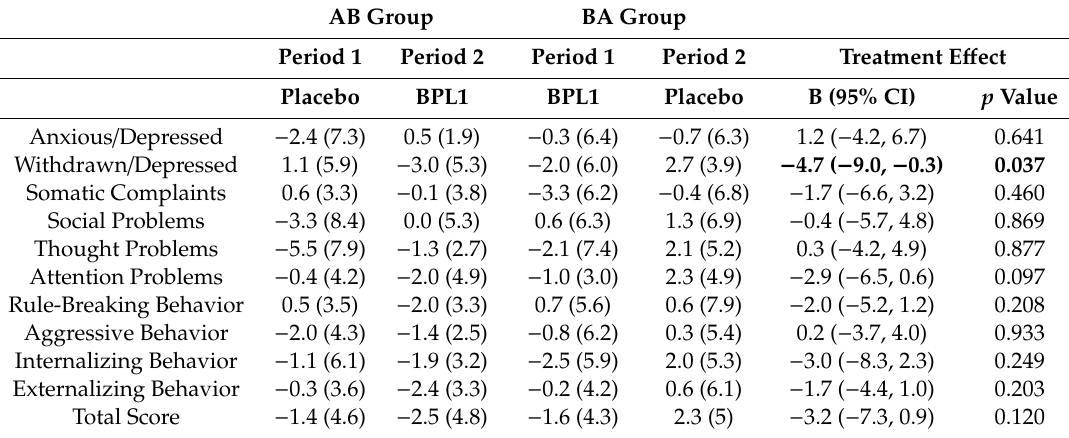
Table 4. Treatment e ff ects on mental health